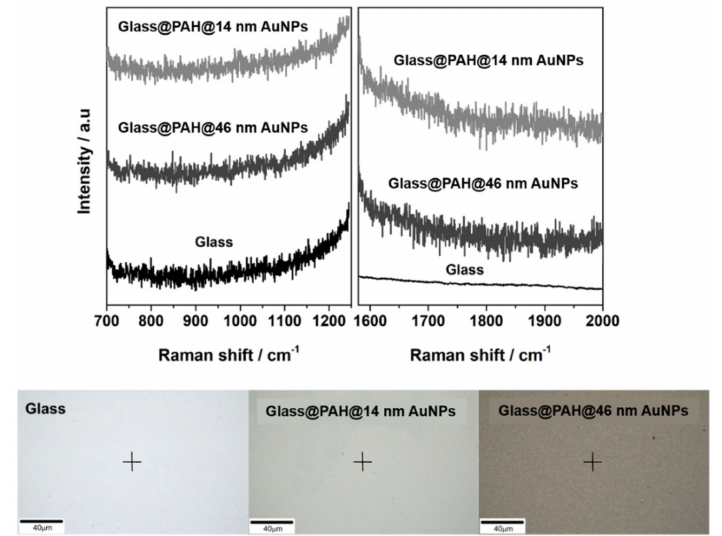
Figure A10. Representative Raman spectra for the substrates and glass slides without the presence of plastic particle samples. The spectra are split into the Raman shift range relevant for PS particles ( left ) and PET particles ( right ). The spectra are shown above images of the ROIs that the spectrum were obtained from, and the images are labelled with the relevant sample title. Laser power, scan speeds, and number of averaged accumulations for the samples can be viewed in Table A1. Scale for all is 40 µ